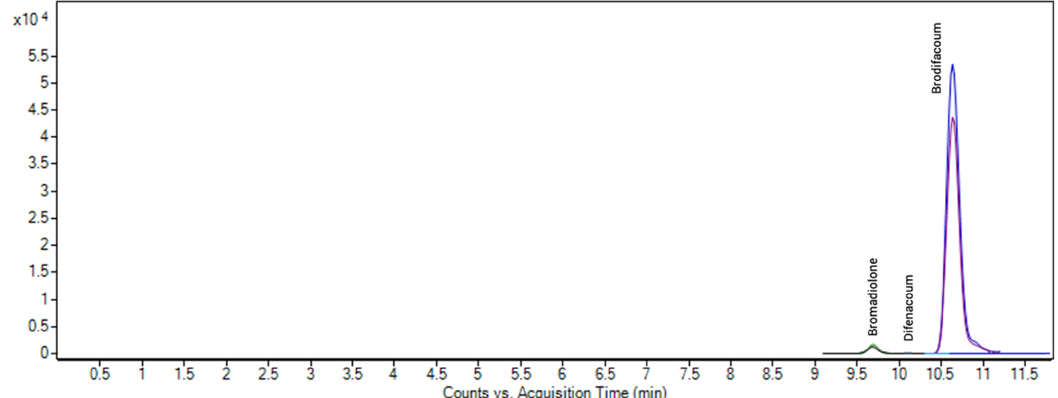
Figure 5. Chromatogram with the identification of brodifacoum, bromadiolone and difenacoum in soil underneath the remains of dead animal in the context of a forensic investigation.